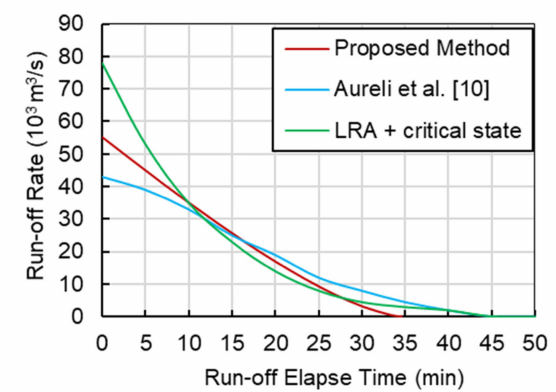
Figure 8. The Malpasset dam hydrograph comparison between the proposed method of this paper, method of Aureli et al. [10] and Level Reservoir Approximation together with the imposition of the critical state at the dam site during the emptying process, Aureli et al.